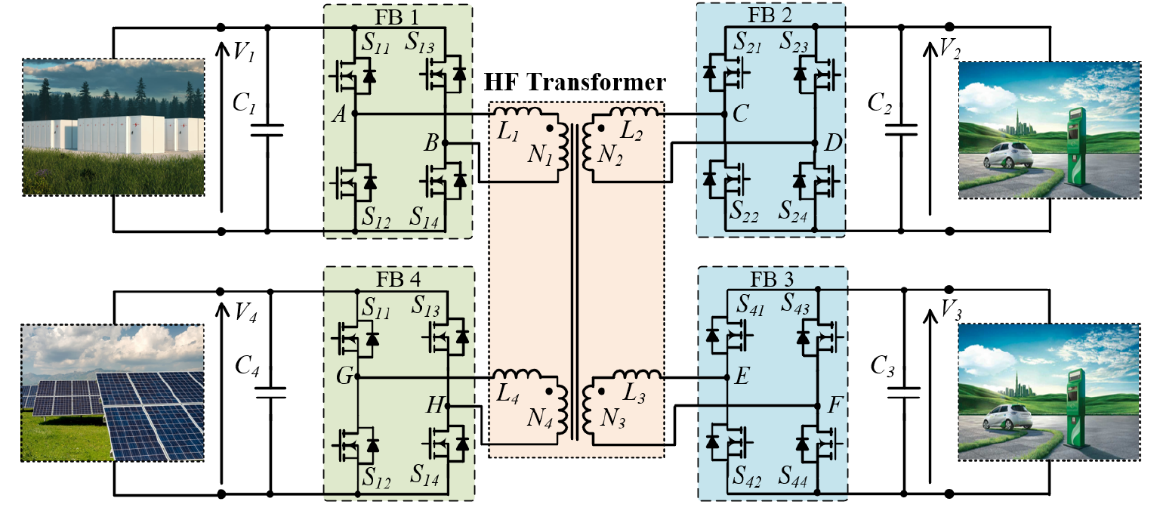
Figure 8. Multi-port bidirectional dual active bridge converter.